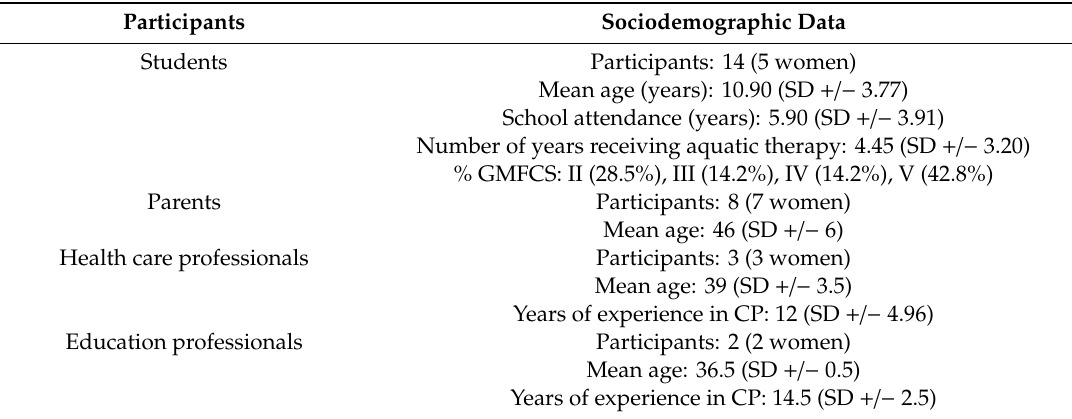
Table 1. Sociodemographic data of